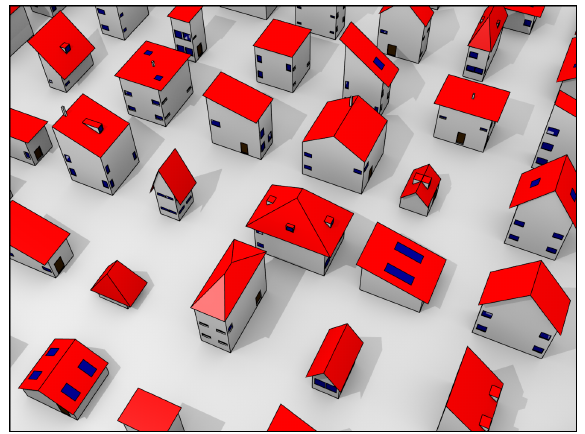
Figure 4: Visualisation of a small spatial extent of the LOD3 dataset that is a semantically enriched boundary representation.